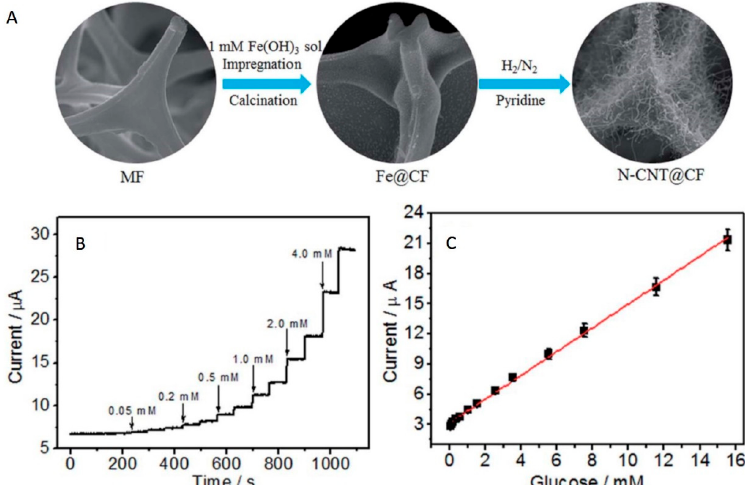
Figure 9. ( A ) Schematic illustration for the preparation of nitrogen-doped CNT@3D graphene foam. ( B ) Current-time curve of glucose oxidase on nitrogen-doped CNT@3D graphene foam for different concentrations of glucose in stirred 0.1 M O 2 -saturated PBS (pH 7.0) at − 0.45 V. ( C ) Calibration curve of the glucose oxidase on nitrogen-doped CNT@3D graphene foam for glucose. Reproduced with permission from ref.